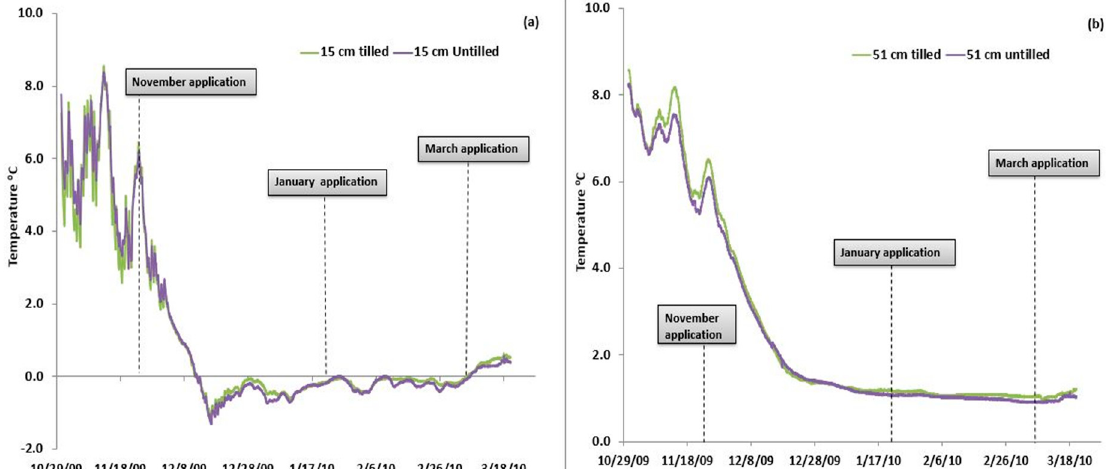
Figure 7. Below ground soil temperature at ( a ) 15 cm, and ( b ) 51 cm soil depth for untilled and fall-tilled treatments (mean overall manure treatments); Brookings, SD.